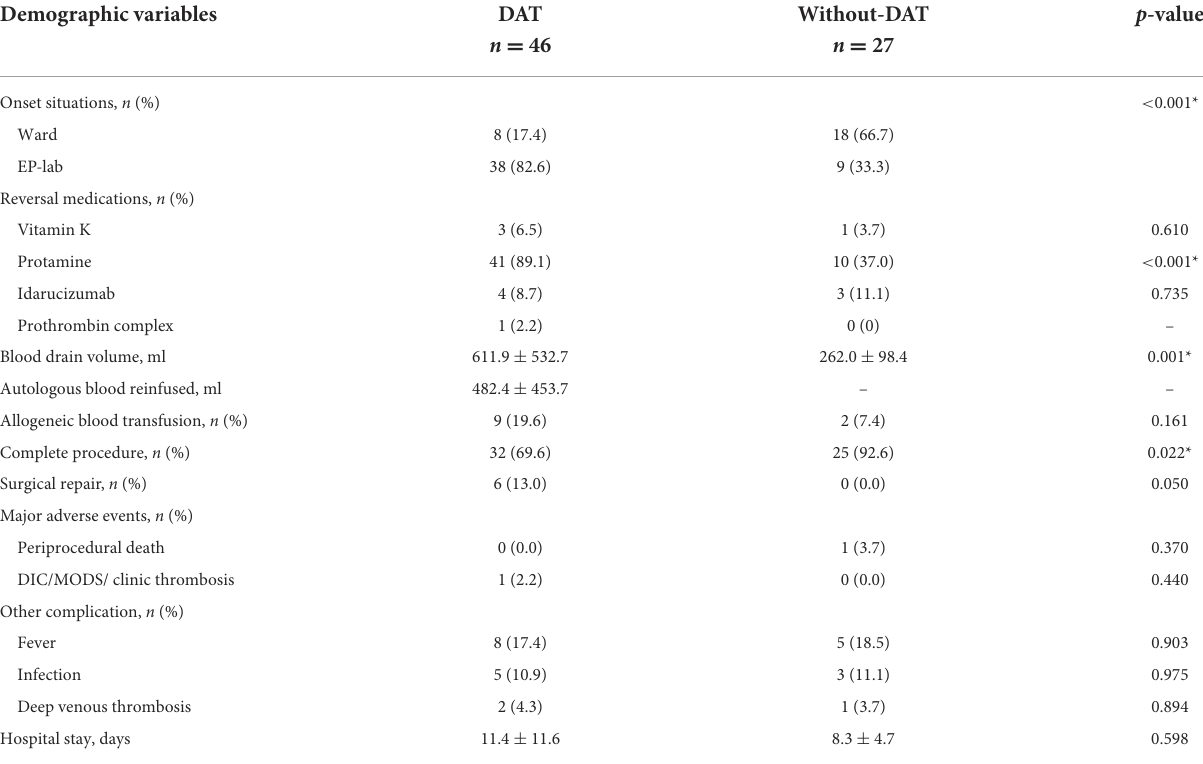
TABLE 3 Comparison of complications between patients with DAT and without-DAT. Demographic